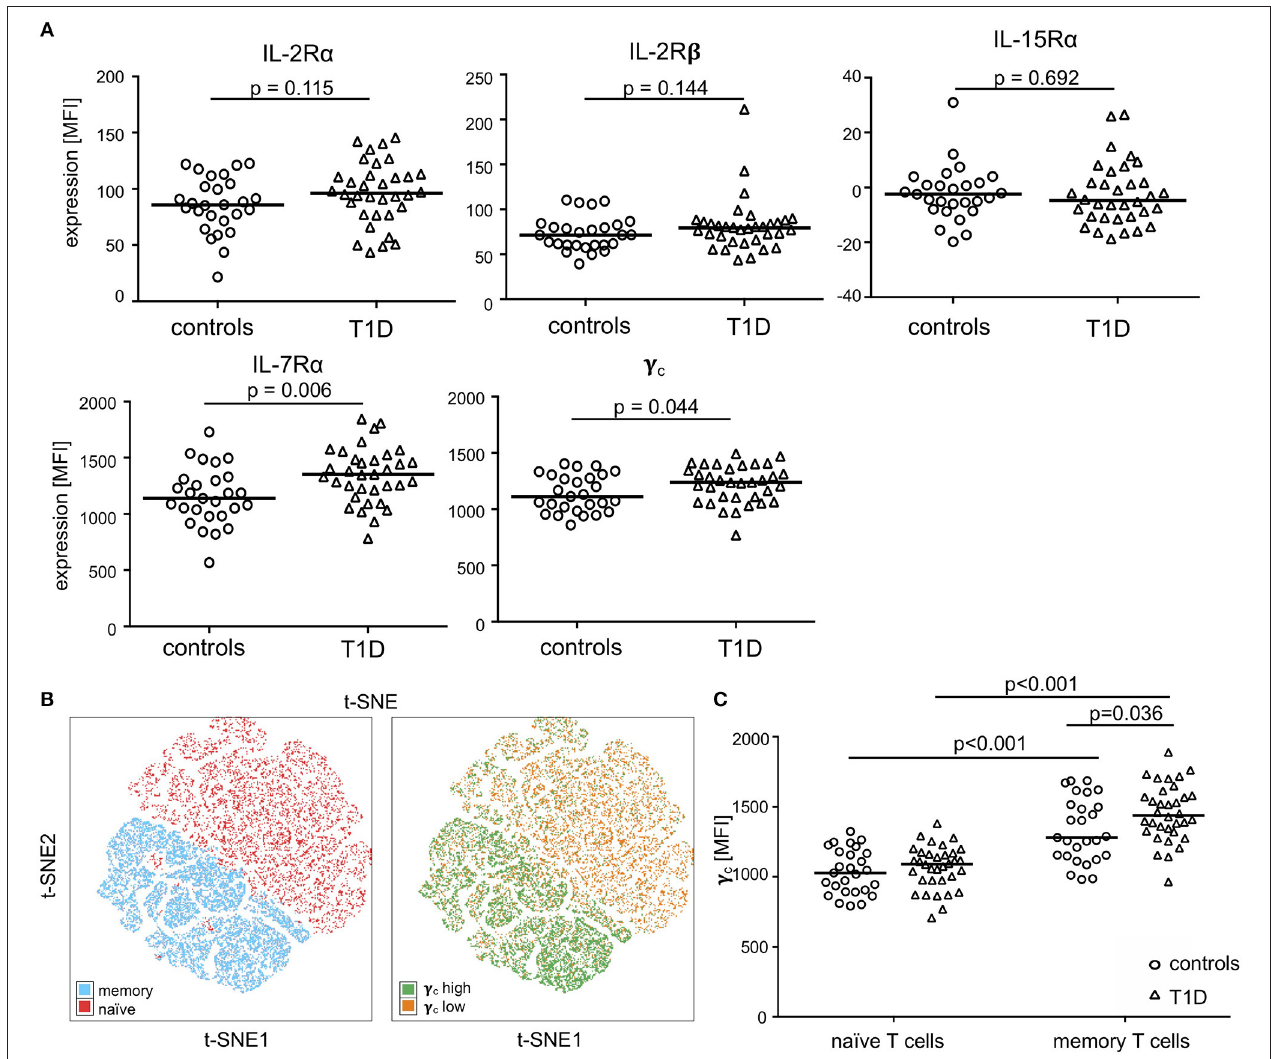
FIGURE 1 | Expression of the γ c cytokine receptor chains on naïve and memory CD4 + T-cells. (A) Expression of γ c , IL-7R α , IL-2R α , IL-2Rß and IL-15R α on CD4 + T-cells of healthy children (controls, n = 27, open circles) and children with T1D (T1D, n = 34, open triangles) are shown as (geometric) mean fluorescence intensity (MFI). Each symbol represents the mean of triplicates for an individual donor. Median values of groups are indicated and nominal p -values of the two-tailed Mann-Whitney U-test are provided. (B) Unbiased t-distributed Stochastic Neighbor Embedding (t-SNE) analysis of a concatenated subgroup of CD4 + T-cells from healthy controls ( n = 11) and T1D patients ( n = 19) illustrate distribution of naïve CD45RA high and memory CD45RA low (red and blue, respectively; left panel) and γ c high (top 10% mean fluorescence of all CD4 + cells; green) and γ c low (bottom 90% mean fluorescence; orange) (right panel) CD4 + T-cells. t-SNE calculates two-dimensional depiction of multi-factorial similarity. These two dimensions are characterized by t-SNE1 and t-SNE2 in given graphs. (C) γ c expression of naïve CD45RA high and memory CD45RA low CD4 + T-cells are shown for healthy controls ( n = 27, open circles) and T1D patients ( n = 34, open triangles). Median values of groups and statistically significant nominal p -values for the Mann-Whitney U-test (two-tailed) are